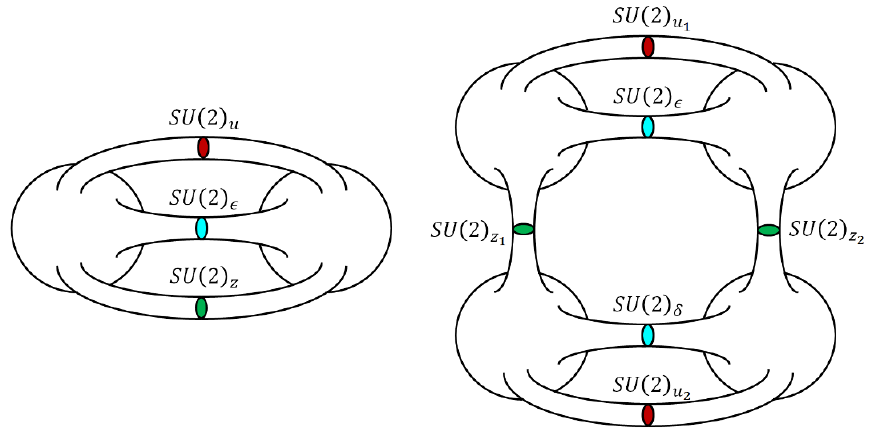
Figure 5 . An illustration of a genus g surface in a pair of pants decomposition. On the left is a genus two surface and on the right a genus three surface. The surfaces are constructed by gluing together the trinion with (cid:8)-gluing along matching types of